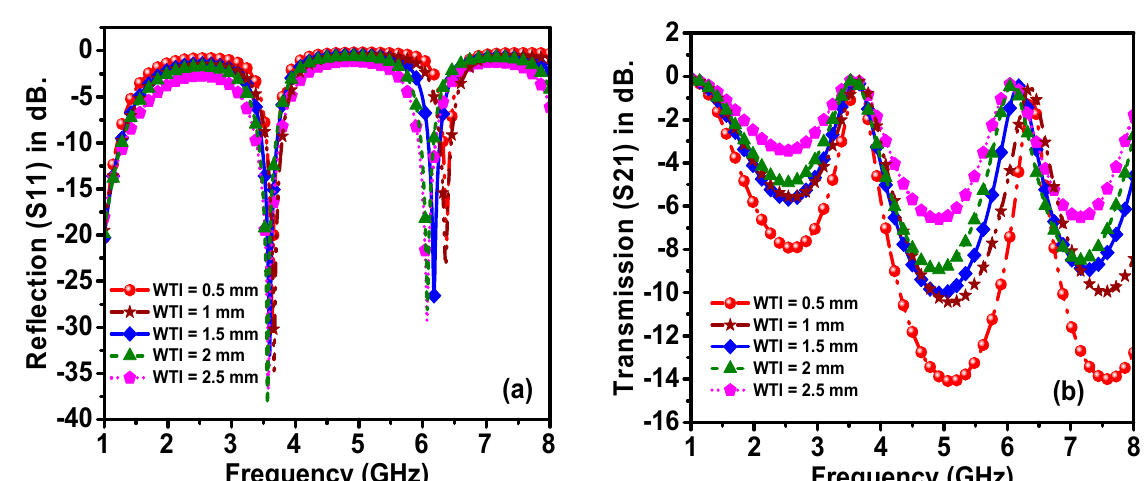
Figure 8. Effect of transmission line width on the resonance frequency of ( a ) reflection and ( b ) transmission spectra.